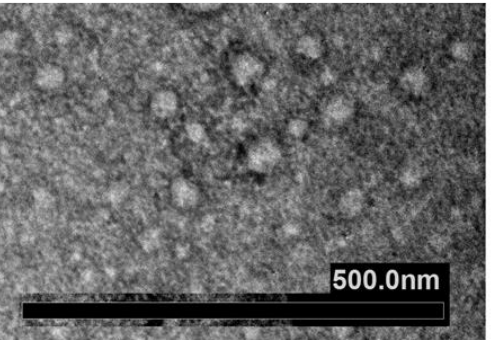
Figure 9. Immuno-electron detection and negative staining used to reveal the presence of exosome membrane protein labeled with gold particles.